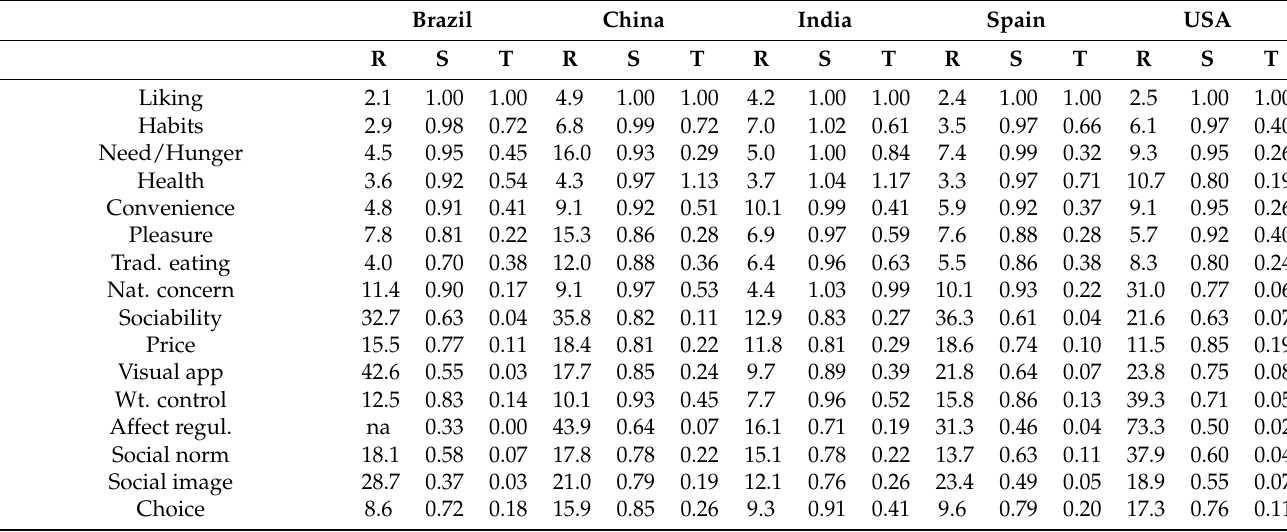
Table 3. Ratios of RATING “apply” responses to RATA “apply” responses (R) and standard indices of importance for RATING (S) and RATA (T) “apply” responses for each motivation construct to the liking motivation construct for dairy foods in all five countries.